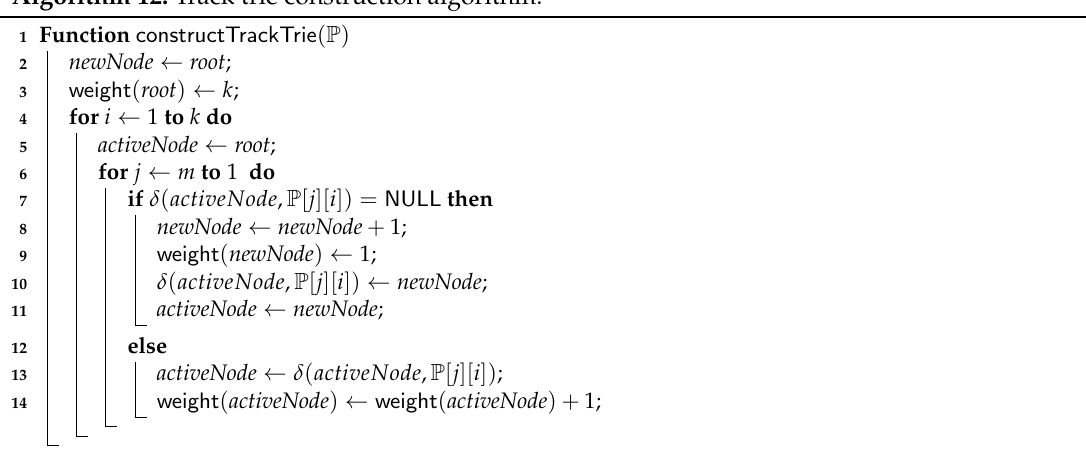
Algorithm 12: Track trie construction